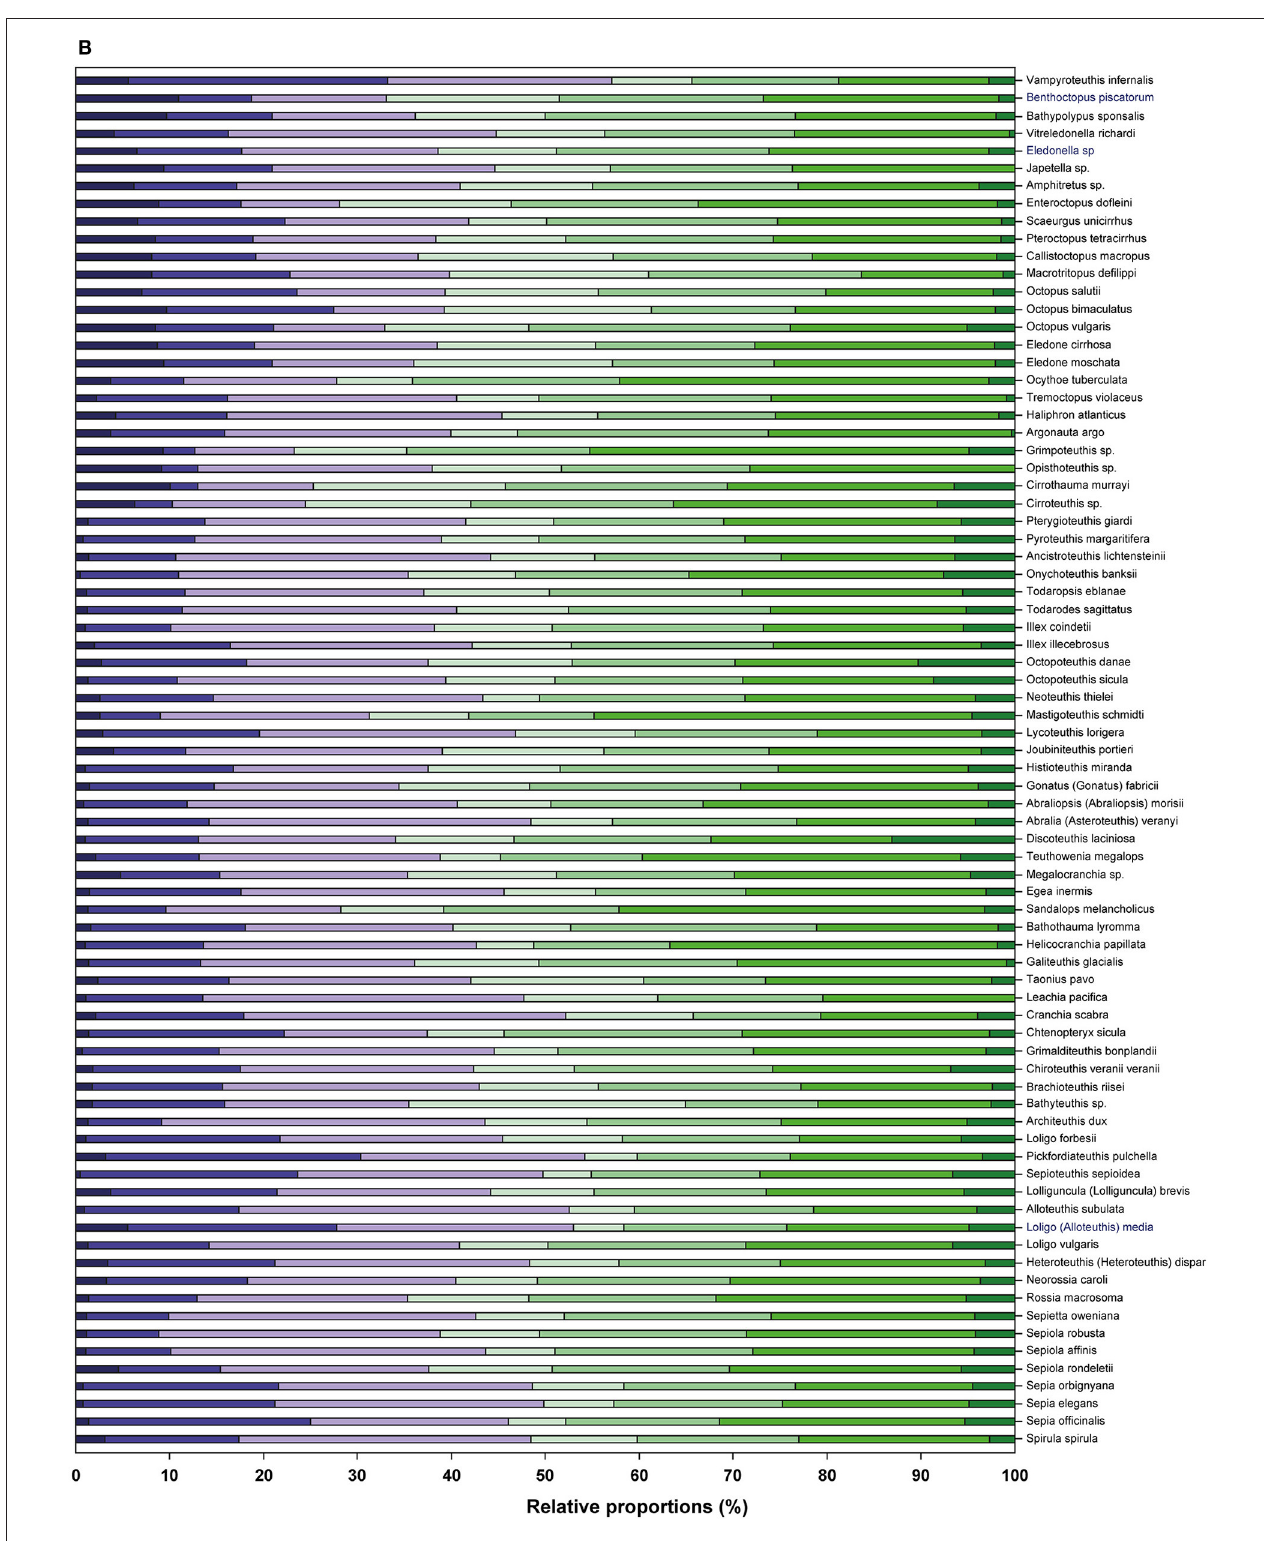
FIGURE 1 | Proportions of the eight functional sets on the whole brain (A) in the 78 species of cephalopods considered in this study (see also Supplementary Table 3 for values). The functional sets (see Supplementary Table 2 for details) are color coded. For supraoesophageal mass: INFF ( ), VERT ( ), BASAL ( ); for suboesophageal mass: BRAC ( ), PEDAL ( ), PALL ( ), CHRF ( ); for optic lobes (OPTIC, ). (B) 100% Stack Bar graph of the relative proportions of the functional brain sets excluding OPTIC, to illustrate variability of brain areas identified in supra- and suboesophageal masses between species.